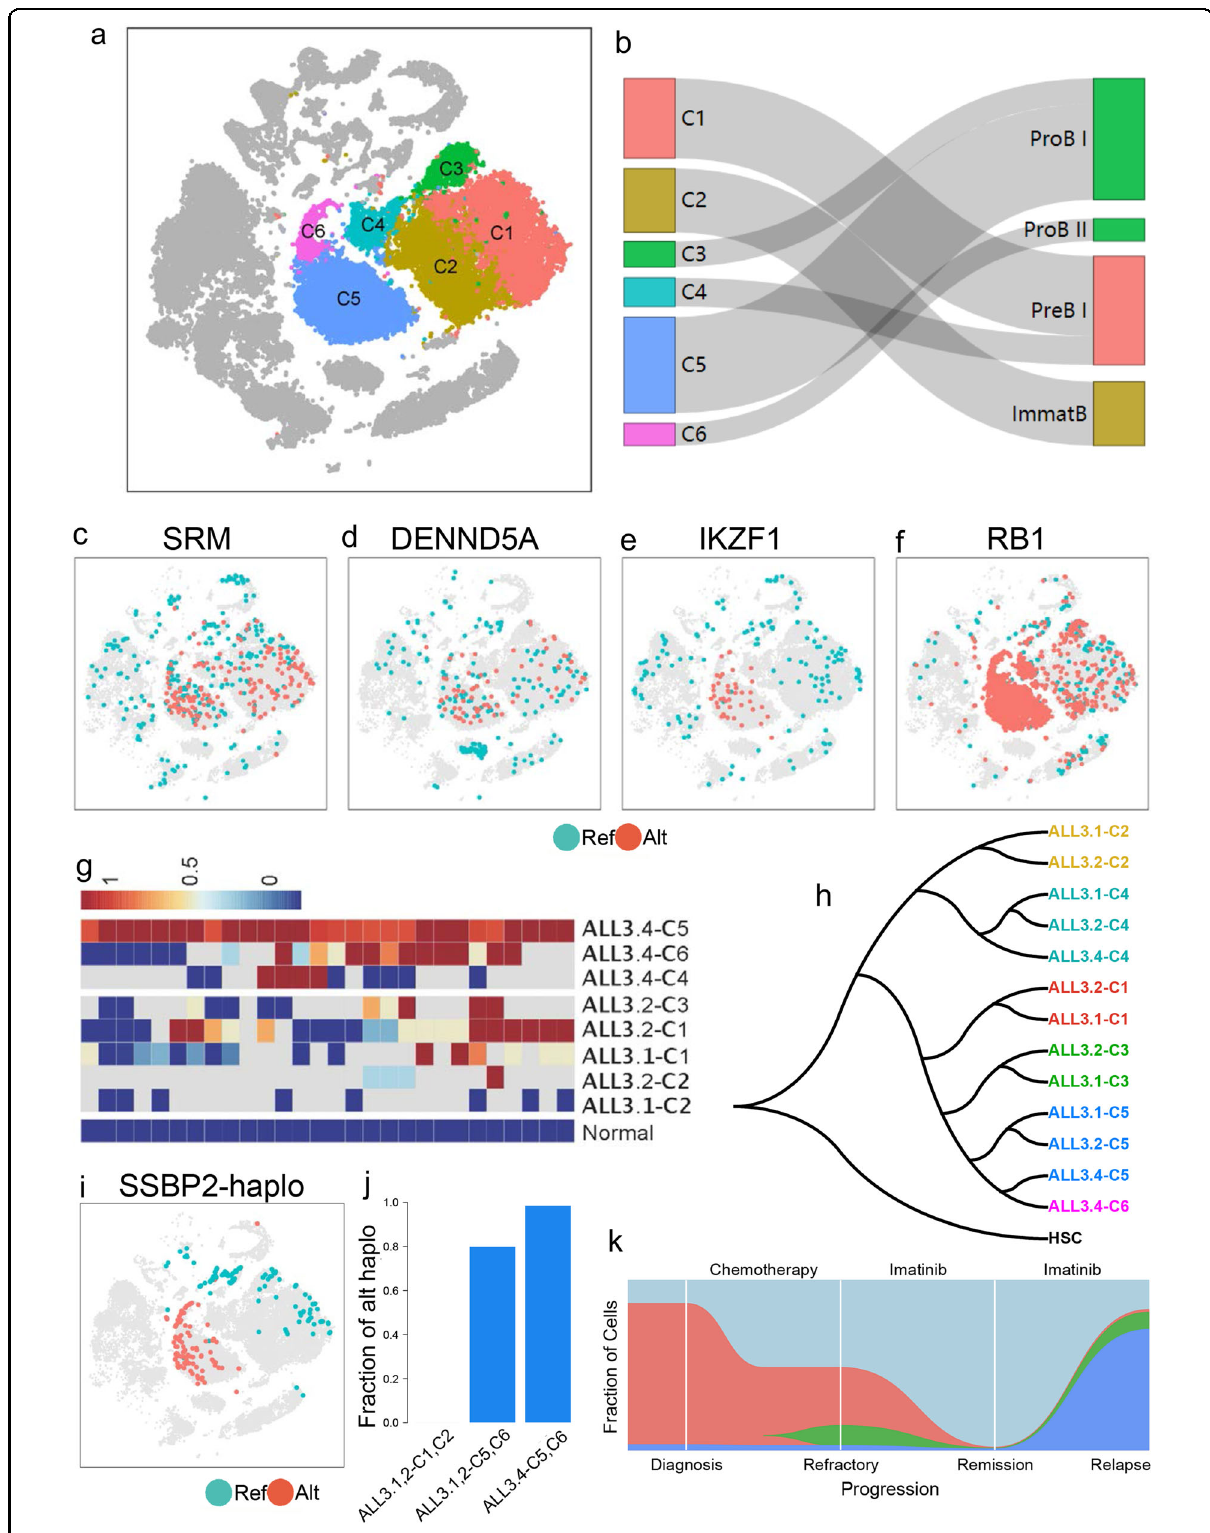
Fig. 6 (See legend on next